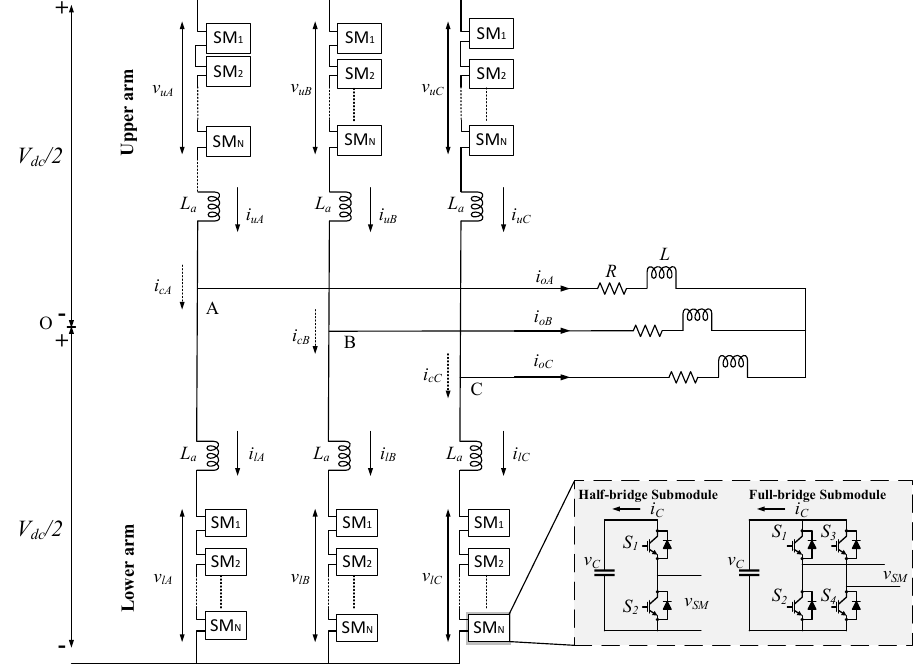
Figure 13. Topology of modular multilevel converter (MMC) with half-bridge and full-bridge configurations.